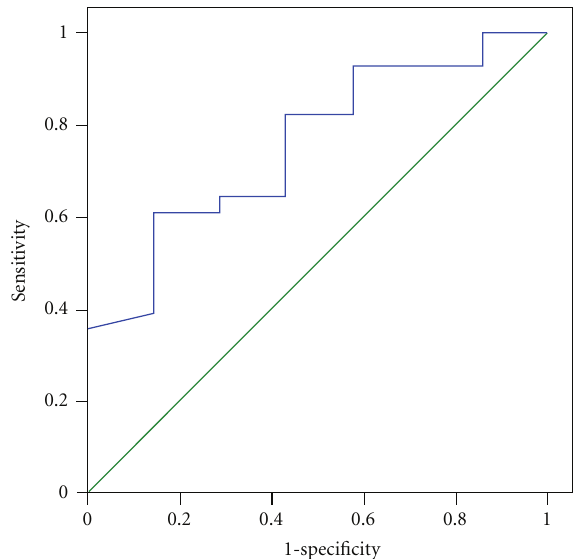
Figure 2: A receiver operating characteristic curve of siderocytes in splenectomized β -thalassemia/HbE